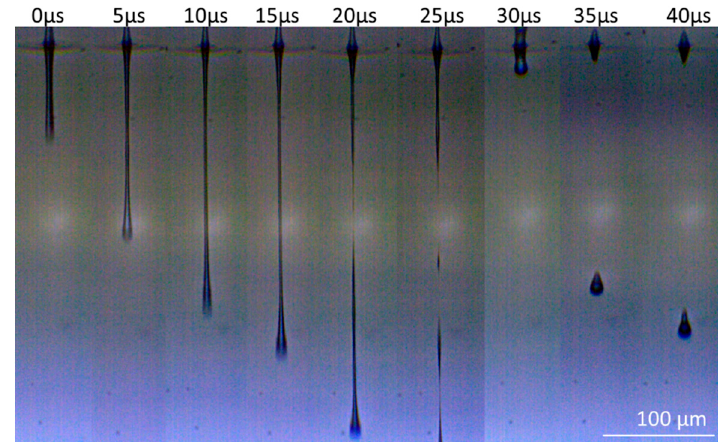
Figure 9. A stroboscopic sequence of shadowgraph images showing the droplet ejection dynamics at pulse energy 𝐸 (cid:2926) = 2.5 µJ, process parameters: λ = 515 nm, film thicknesses 𝑑 (cid:2888) =9.52 µm liquid donor, pulse energy E p = 2.5 µ J, process parameters: λ = 515 nm, film thicknesses d D = 9.52 µ m liquid donor, and 𝑑 (cid:2900)(cid:2893) = 3.5 µm polyimide and d PI = 3.5 µ m